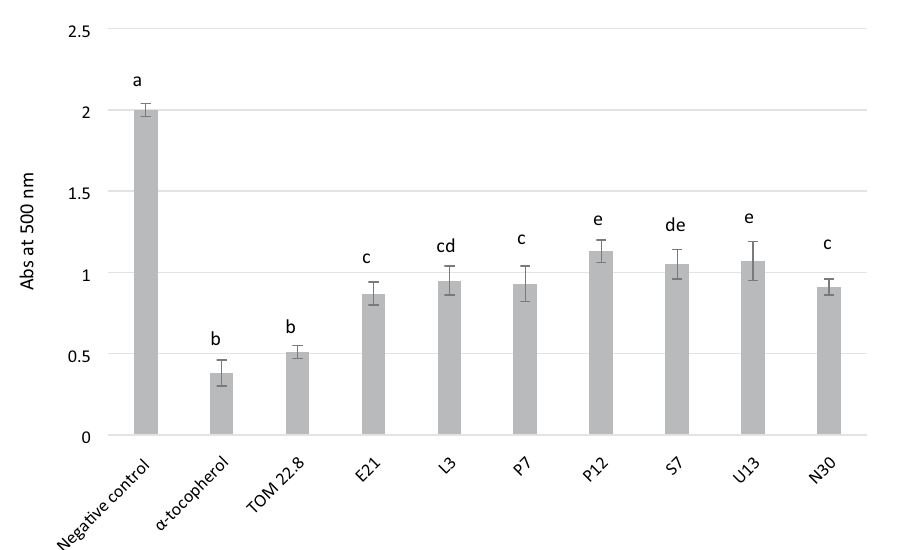
Figure 1. Lipid peroxidation inhibitory activity (Abs at 500 nm) of the tested lactobacilli strains. The activity was measured under a linoleic acid oxidation system for 8 days. α-Tocopherol (1 mg/ml) was used as positive control. Data are the means from three independent experiments. Bars represent standard deviations. Letters a–e indicate P <